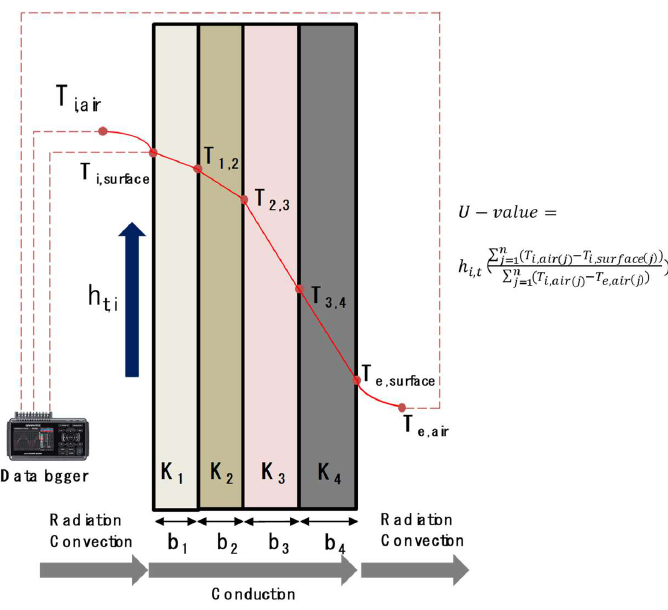
Figure 2. The air-surface temperature ratio ( ASTR) method.